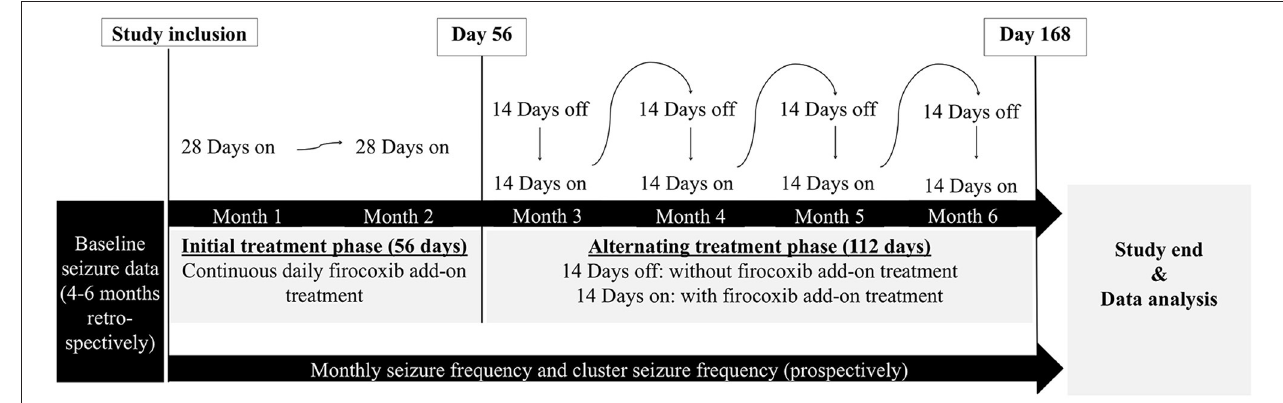
FIGURE 1 | Schematic illustration of the study design. The study course consisted of a continuous treatment period for the first 56 days, followed by a 14-day alternating treatment period for 112 days (total study period 168 days). The alternating treatment protocol was selected to lower the risk of potential firocoxib adverse events. Antiseizure medication was not changed during the firocoxib add-on phase, use of diazepam rectal tubes for emergency management of seizures was allowed. Clinical examinations and blood tests were performed on a regular base throughout the entire study period. Study participation was denied to any dog with pre-existing signs of gastrointestinal disease, renal disease or pre-treatment with any non-steroidal anti-inflammatory drug or